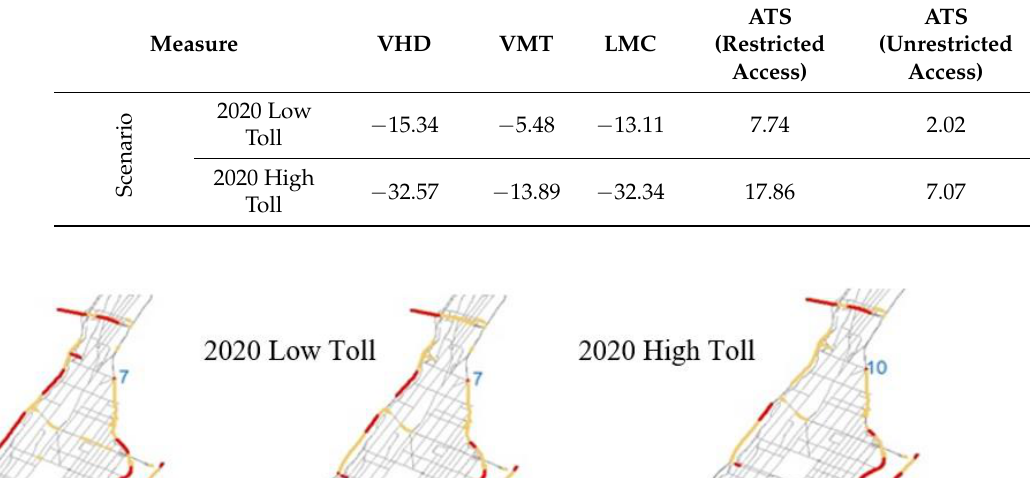
Table 1. Percentage change in Manhattan network measures in pricing scenarios.